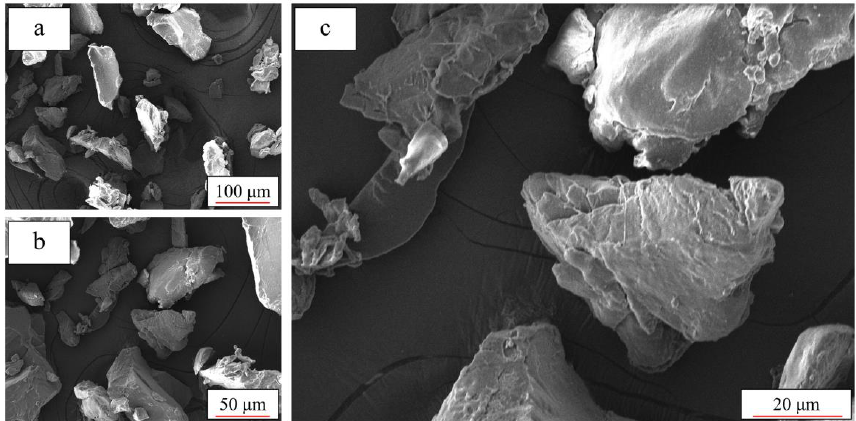
Figure 17. Microstructure of reused TPU powder under different magnifications: ( a ) 500×; ( b ) 1000× and ( c ) 2000×.